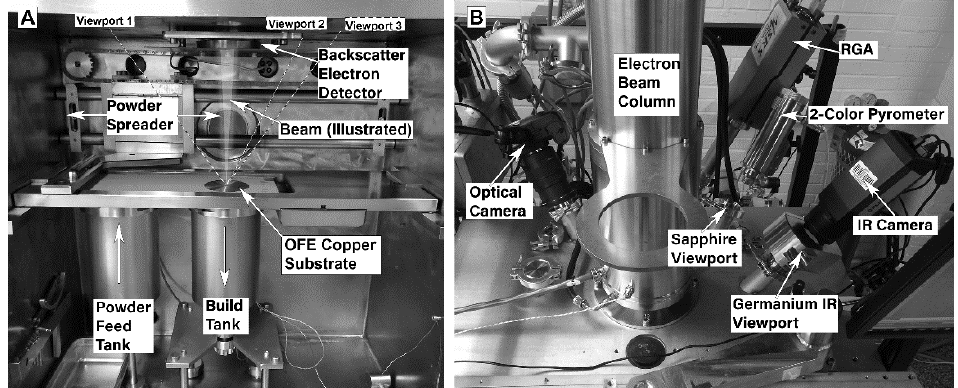
Figure 2. Photographs of the customized Arcam A2 electron beam melting system, showing the interior of the vacuum chamber, mechanical components and in-situ backscatter electron (BSE) detector ( A ), and the exterior of the vacuum chamber, showing the electron beam column and the location of instrumentation and viewports ( B ). The line of sight of the visible light camera, pyrometer, and IR camera are illustrated by the dashed lines in 2A, from viewports 1, 2, and 3, respectively.